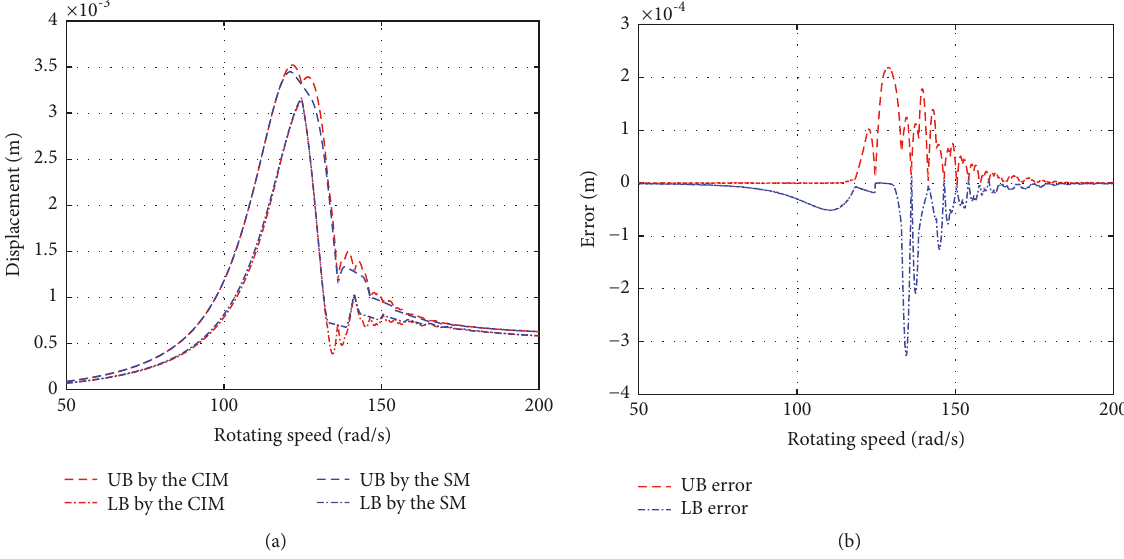
Figure 4: (a) Transient response of the rotor with uncertain support stiffness 2 and (b) calculation